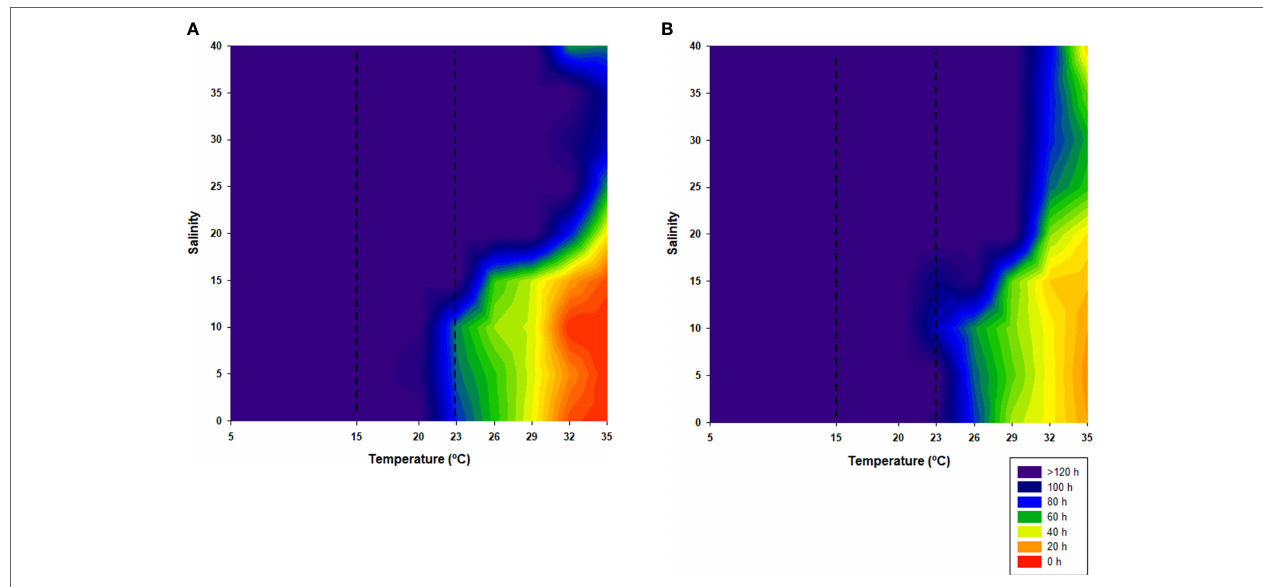
FIGURE 3 | Median lethal time (Lt50) for juveniles (A) and adults (B) . Dotted lines represent the established control temperature range